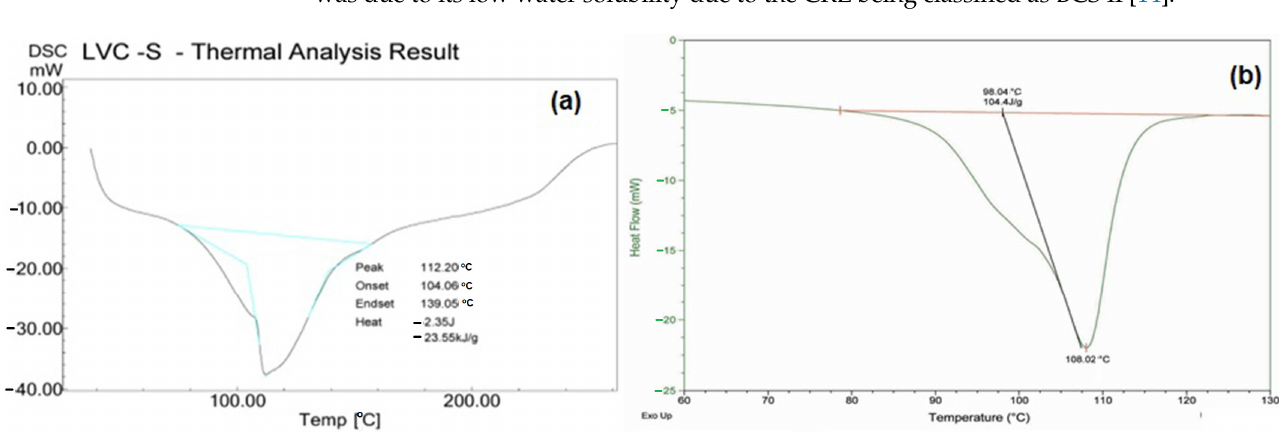
Table 3 . In vitro release kinetics of pure CRL, CRL-MC, and -NCs (mean ± SD, n = 3). Coefficient of Correlation (r 2 )